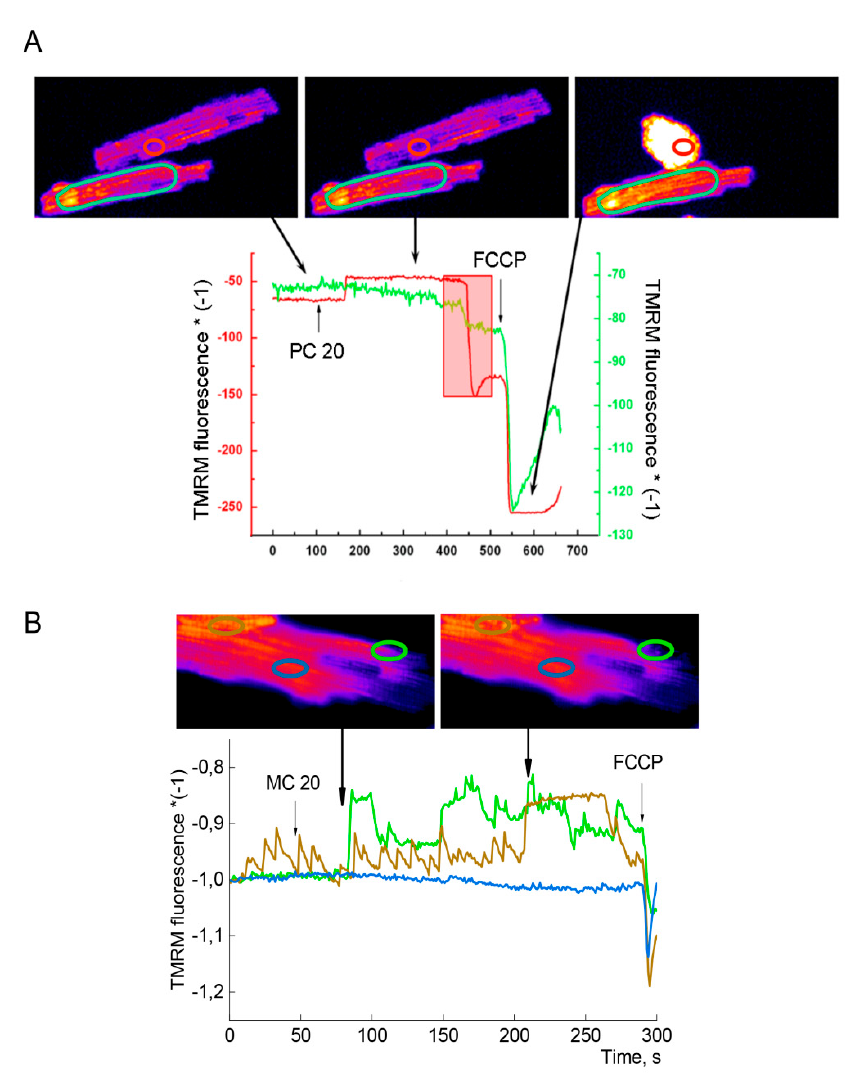
Figure 6. Variability of ∆Ψ m responses to PC in isolated CM. Variety of ∆Ψ m responses to 20 µ M PC in two cells (panel A ) and to 20 µ M MC in nearby compartments of one cell (panel B ). TMRM fluorescence, as a measure of ∆Ψ m , is depicted in red and green traces for top and bottom cells in panel A, respectively. In panel ( B ), 3 colored TMRM traces correspond to signals from 3 limited oval areas at one cell. Uncoupler FCCP (1 µ M) wad added for dissipation of ∆Ψ m . Red hatched box corresponds to time period of top cell contraction evoked by PC ( A ).